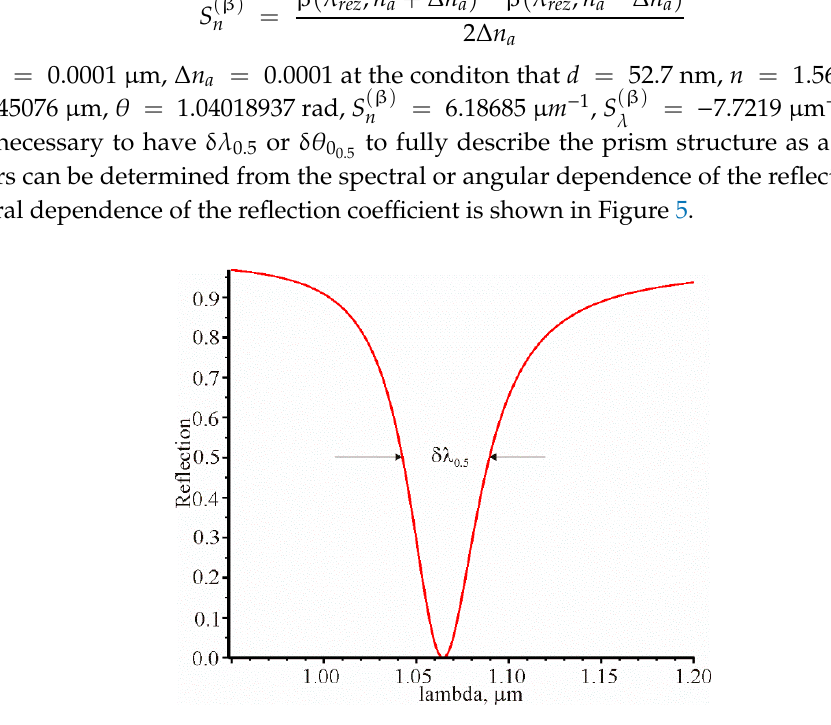
Figure 5. Spectral dependence of the reflection coefficient with the following parameters: (cid:2019) (cid:3045)(cid:3032)(cid:3053) = Figure 5. Spectraldependenceofthereflectioncoefficientwiththefollowingparameters: λ rez = 1.0645076 µ m, 1.0645076 μm, (cid:2016) (cid:3045)(cid:3032)(cid:3053) = 1.04018937, (cid:1856) = 52.7 nm, (cid:1866) = 1.56, (cid:1866) (cid:3028) = 1.3242. In this case, δ(cid:2019) (cid:2868).(cid:2873) = θ rez = 1.04018937, d = 52.7 nm, n = 1.56, n a = 1.3242. In this case, δ 0.0471 μm.